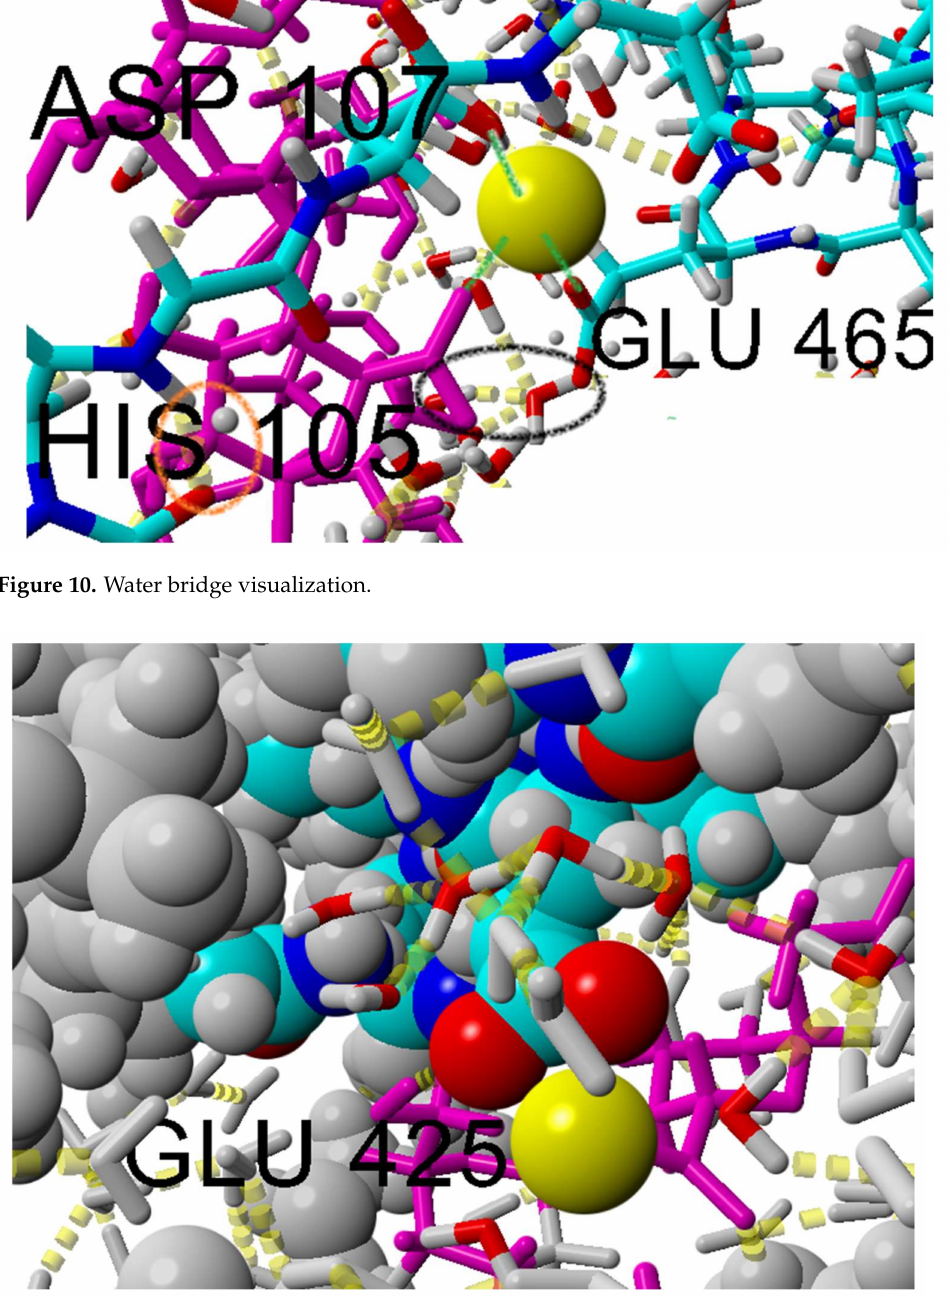
Figure 11. Cation bridge visualization. Cation bridges are defined as places at which a cation creates ionic interaction with both HSA and HA. These interactions occur between the carboxyl group of HA–ion